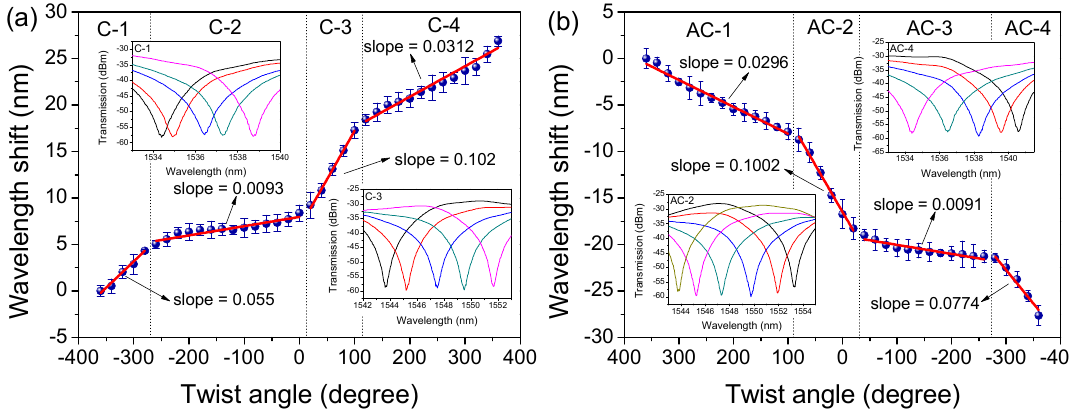
Figure 4. Relationships between the wavelength shift and twist angle in (a) the clockwise direction ( b ) the anticlockwise direction. and (b) the anticlockwise direction.